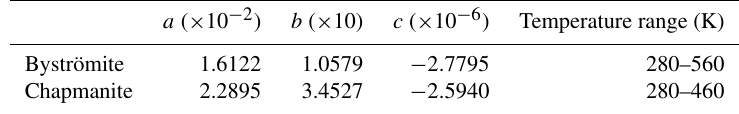
Table 6. Coefficients for the Maier–Kelley heat-capacity polynomial C p = a + bT + cT − 2 for byströmite and